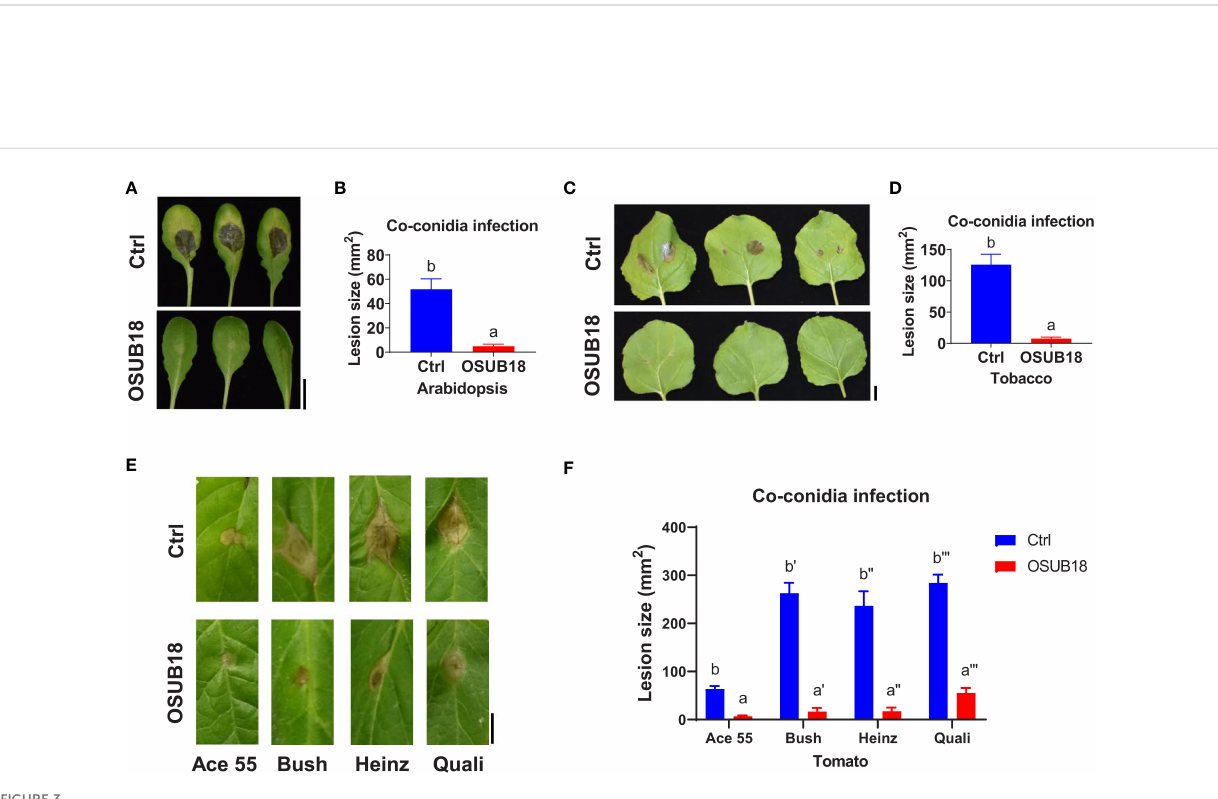
FIGURE 3 OSUB18 co-inoculation protected plants of different species from the B cinerea infections. (A) OSUB18 inhibited B cinerea growth in A thaliana Col-0 leaves after co-inoculation. Scale bar = 10 mm. (B) Quanti fi cation of the fungal disease symptoms in (A) . (C) OSUB18 inhibited B cinerea growth in tobacco leaves after co-inoculation. Scale bar = 10 mm. (D) Quanti fi cation of the fungal disease symptoms in (C) . (E) OSUB18 inhibited B cinerea growth in different tomato leaves after co-inoculation. Scale bar = 10 mm. (F) Quanti fi cation of the fungal disease symptoms in (E) . We mixed an equal volume of water (Ctrl) or OSUB18 cells into the B cinerea inoculum for the phytopathogenic infection assay. Ace55, Bush, Heinz, and Quali are four popular tomato cultivars in the U.S. market. Data present mean ± SE of three biological replicates. Data with different letters indicate a p- value < 0.05 on Student ’ s t-test.